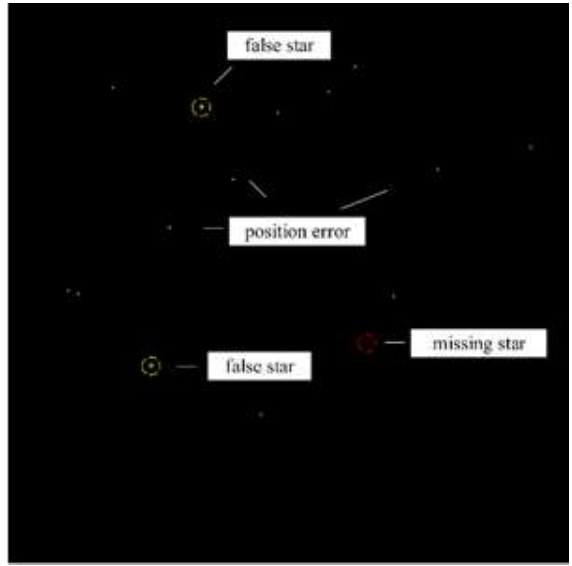
Figure 1. Main challenges in star identification.